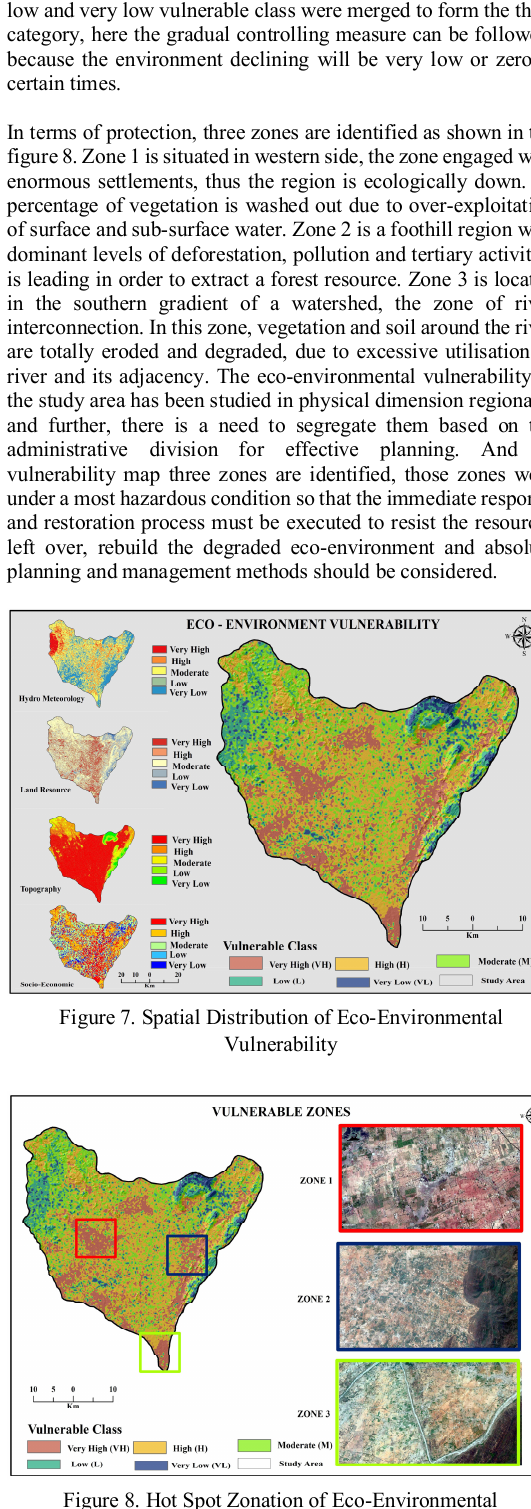
Figure 8. Hot Spot Zonation of